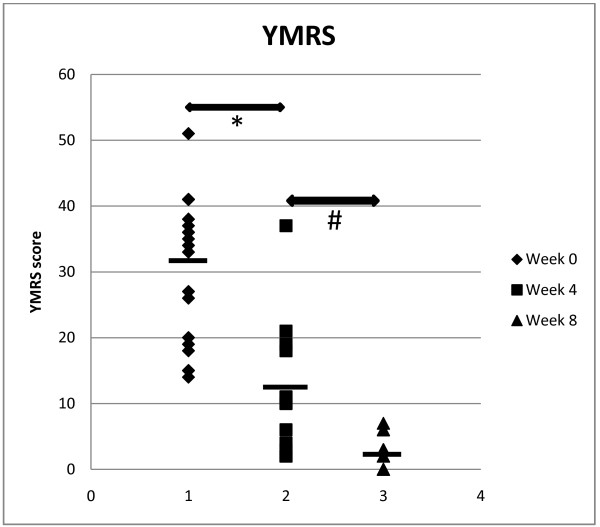
The mean Young ManiaRating Scale (YMRS) scorebefore (0 weeks) andafter 4 and 8weeks of olanzapine treatmentin patients with bipolardisorder (BPD). The mean YMRS score was significantly lower after 4 weeks of treatment with olanzapine (mean YMRS score before medication: 30.31±10.81; after 4 weeks of medication: 10.53±9.82; Wilcoxon rank sum test: *p= 0.001). The mean YMRS score of the BPD patients was further significantly reduced after 8 weeks after medication compared with the score after 4 weeks of medication (YMRS score after 8 weeks of medication: 2.5±2.20; Wilcoxon rank sum test: #p= 0.005). The YMRS mean scores before and after treatment are indicated by horizontal lines.